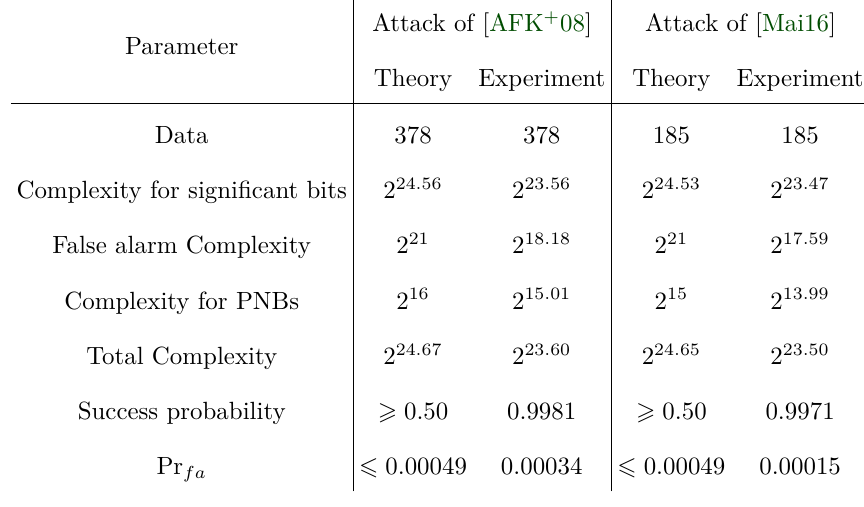
Table 3: Comparison of theoretical claim and experimental results of the implemented attack on 3.5 round Toy